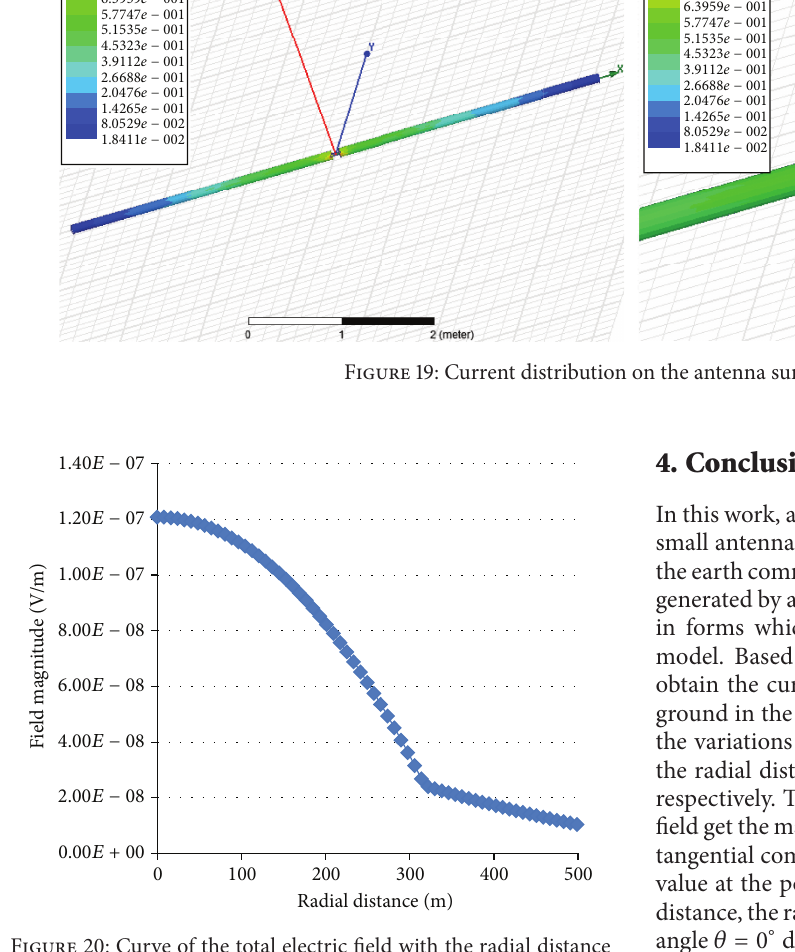
Figure 20: Curve of the total electric field with the radial distance by